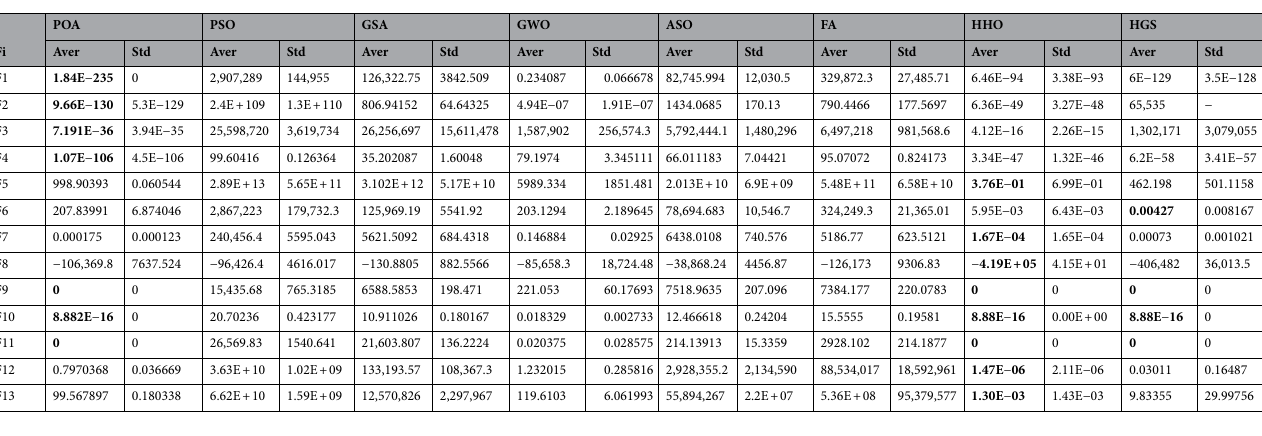
Table 5. Results of the first 13 benchmark functions with Dim = 1000. Significant values are in bold.